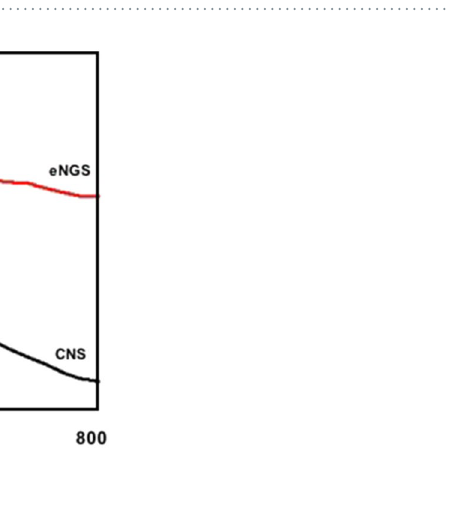
Figure 4. ( a ) C1s spectra of CNS, ( b ) C1s spectra of eNGS, and ( c ) Survey XPS spectra of CNS and eNGS.